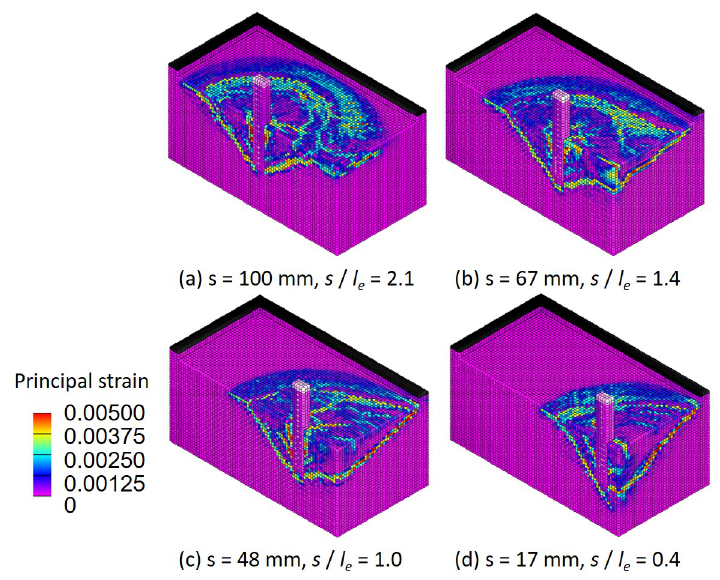
Figure 26. Crack patterns with different distance between the free edge and the anchor